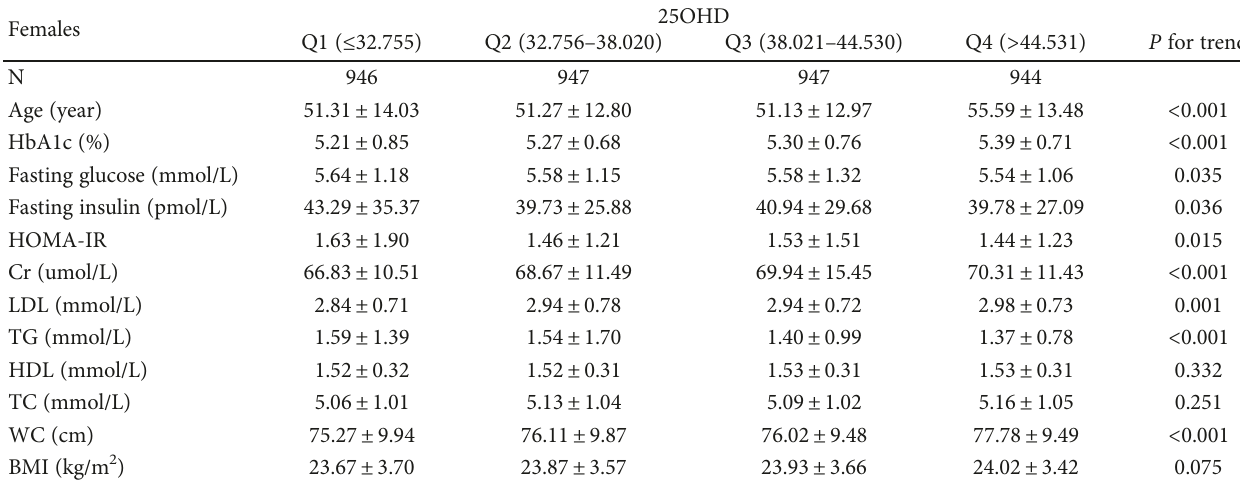
Table 2: Comparison between di ff erent 25(OH)D subgroups in females.